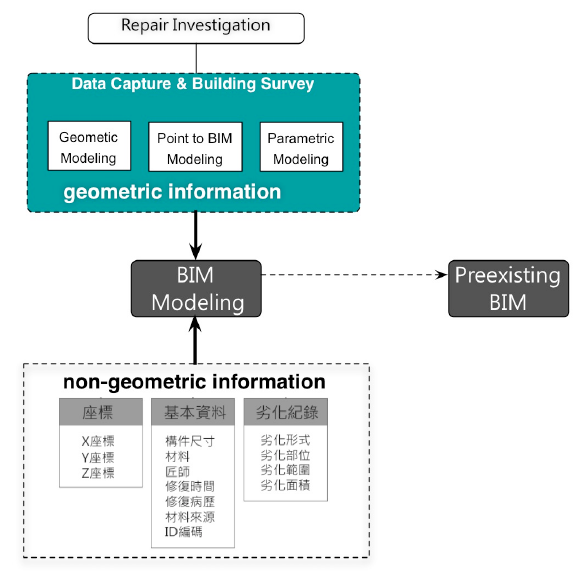
Figure 4. BIM modeling process in repair investigation